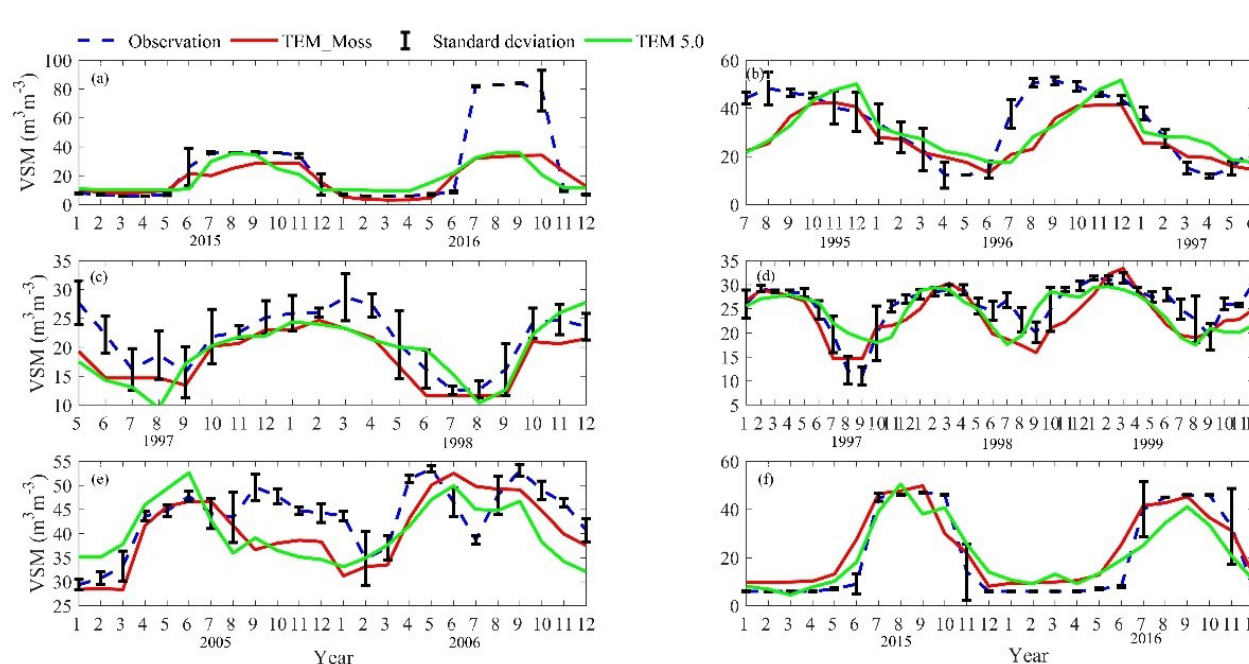
Figure 7. Comparison between observed and simulated volumetric soil moisture (VSM, m 3 m − 3 ) at (a) US-Ivo (alpine tundra), (b) BOREAS NSA-OBS (boreal forest), (c) NL-Loo (temperate coniferous forest), (d) DK-Sor (temperate deciduous forest), (e) US-Bkg (grassland), and (f) US-Atq (wet